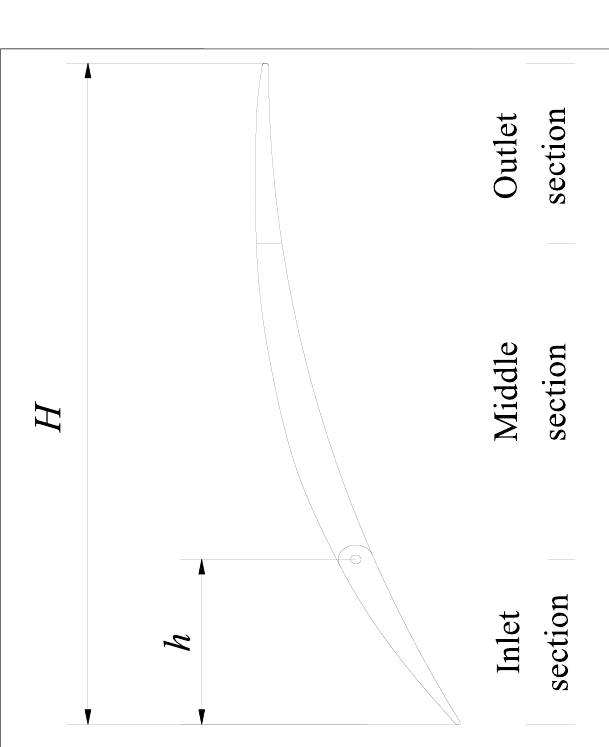
FIGURE 3 | Schematic of guide vane